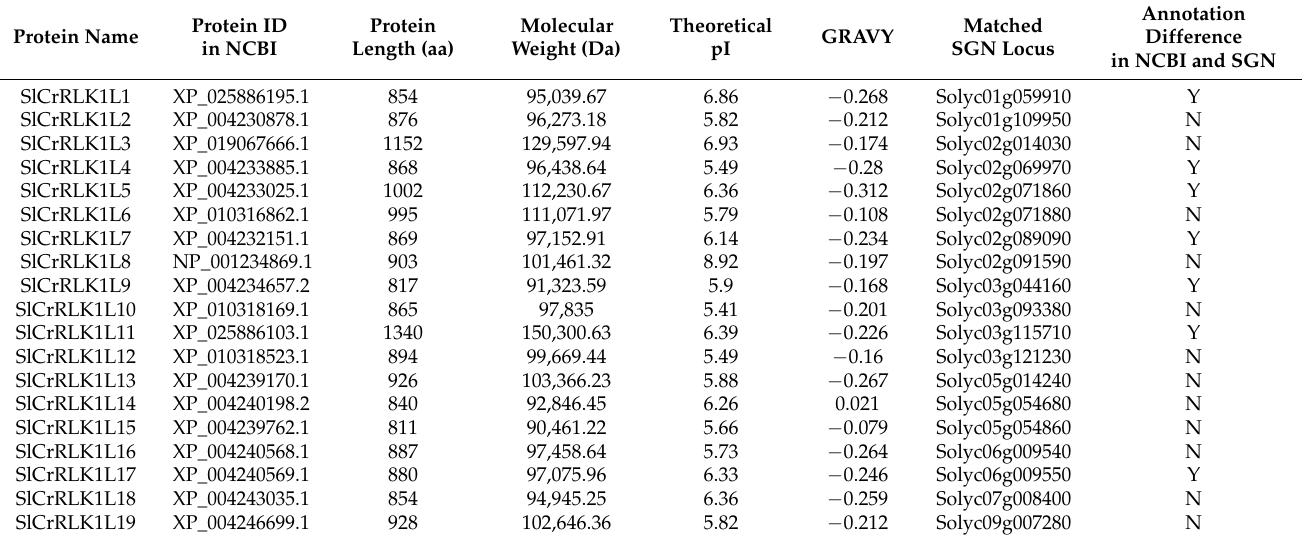
Figure 1. Identification of tomato CrRLK1Ls in the NCBI and SGN databases. The predicted numbers of tomato CrRLK1Ls in the NCBI and SGN databases are shown. PF12819: Malectin-like; PF07714: PK-Tyr-Ser-Thr.